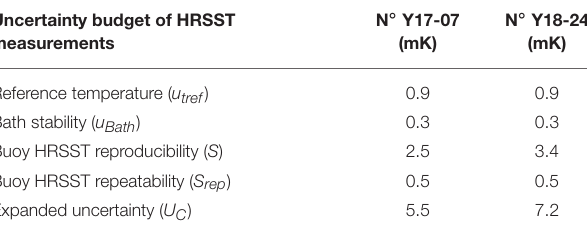
TABLE 4 | Uncertainty budget of buoys HRSST